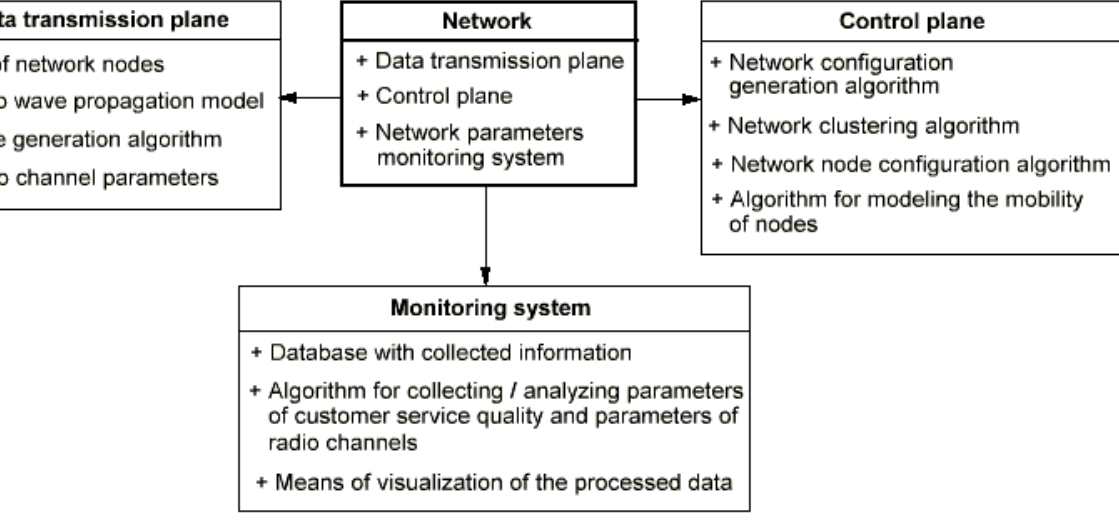
Figure 6. Diagram of network management system operation.